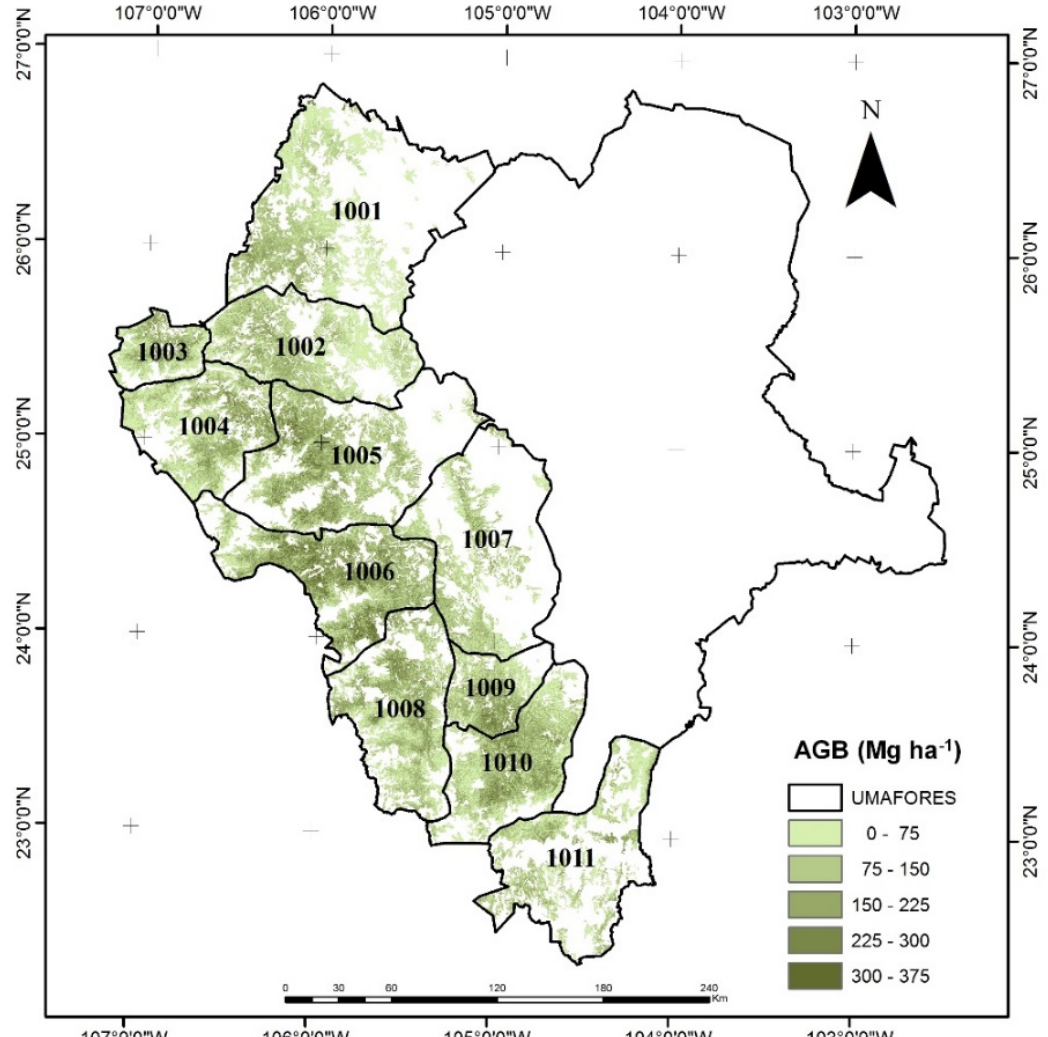
Figure 4. Spatial distribution of the total AGB in the SMO, state of Durango, Mexico.